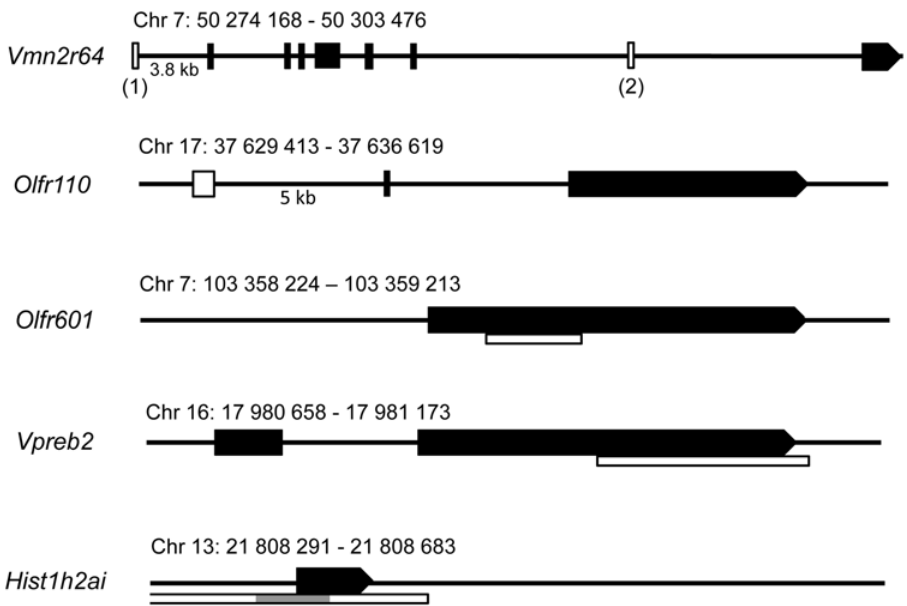
Fig 2. Schematic structures of five candidate genes with six CpG islands. Five candidate genes with six CpG islands were chosen for bisulphite sequencing: Vomeronasal type 2 receptor 64 (Vmn2r64 , 2 CpG islands (1 and 2), Olfactory receptor genes 110 (Olfr110) and 601 (Olfr601) , Pre-B lymphocyte gene 2 (Vpreb2) , and Histone cluster 1 H2ai (Hist1h2ai) . Exons are illustrated in black and CpG islands in white. The bisulphite sequenced part of CpG island of Hist1h2ai is illustrated in